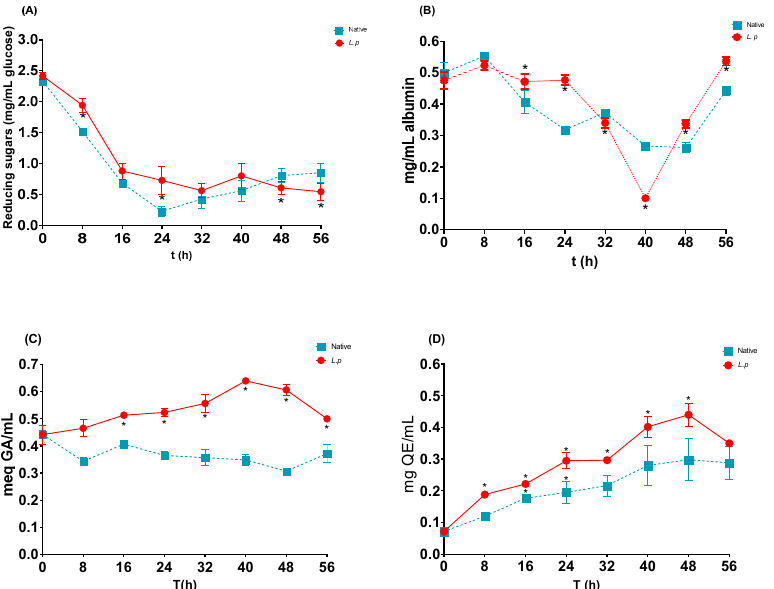
Figure 4. Temporal course of reducing sugars ( A ), protein ( B ), total polyphenols ( C ), and total flavonoids ( D ) of native and controlled fermentation ( Lp ) of the C. ficifolia juice for 56 h. * Significant difference ( p < 0.05) against native fermentation juice. T-paired test (Mean ± S.D., n = 3), Tukey’s post hoc